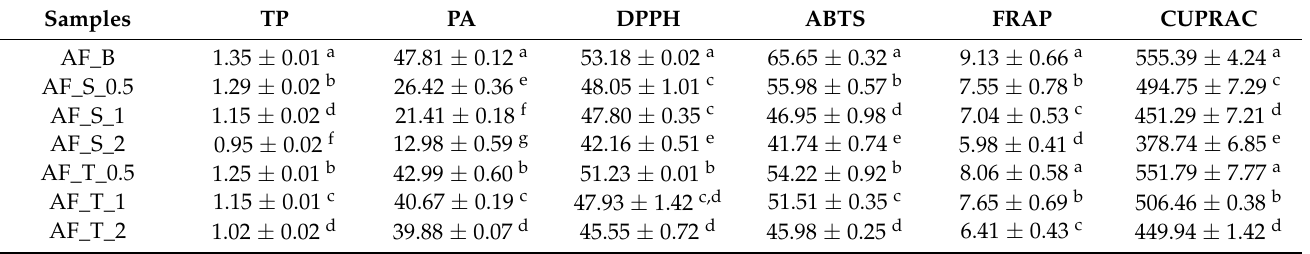
Table 1. Total phenolics (TP), proanthocyanidins (PA), and antioxidant activity of formulated microparticles.